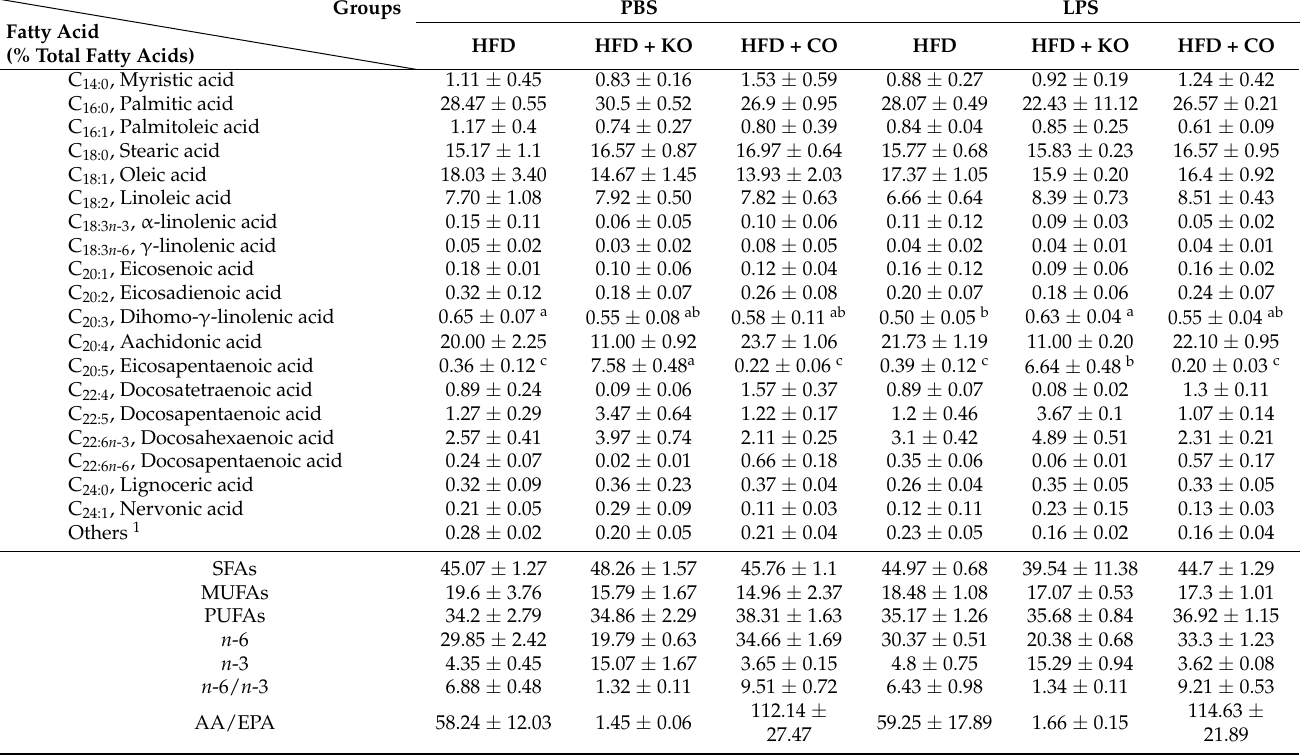
Table 5. Effects of partial replacement of dietary fat with krill oil or coconut oil on the fatty acid composition of whole blood in rats after the LPS